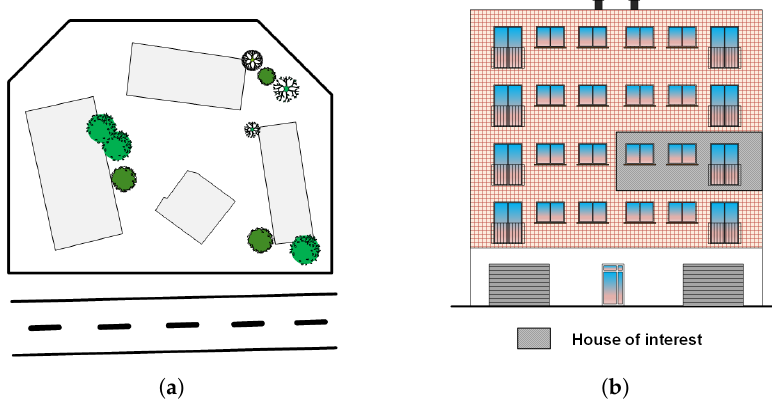
Figure 1. Alternatives of flat or residence to be supported by an acoustic alarm service. ( a ) Residence site, with several buildings/houses with common spaces (dining room, etc.) and with private facilities for elderly or pseudo-dependent; ( b ) Isolated flats where elderly or pseudo-dependent people need variate surveillance support.